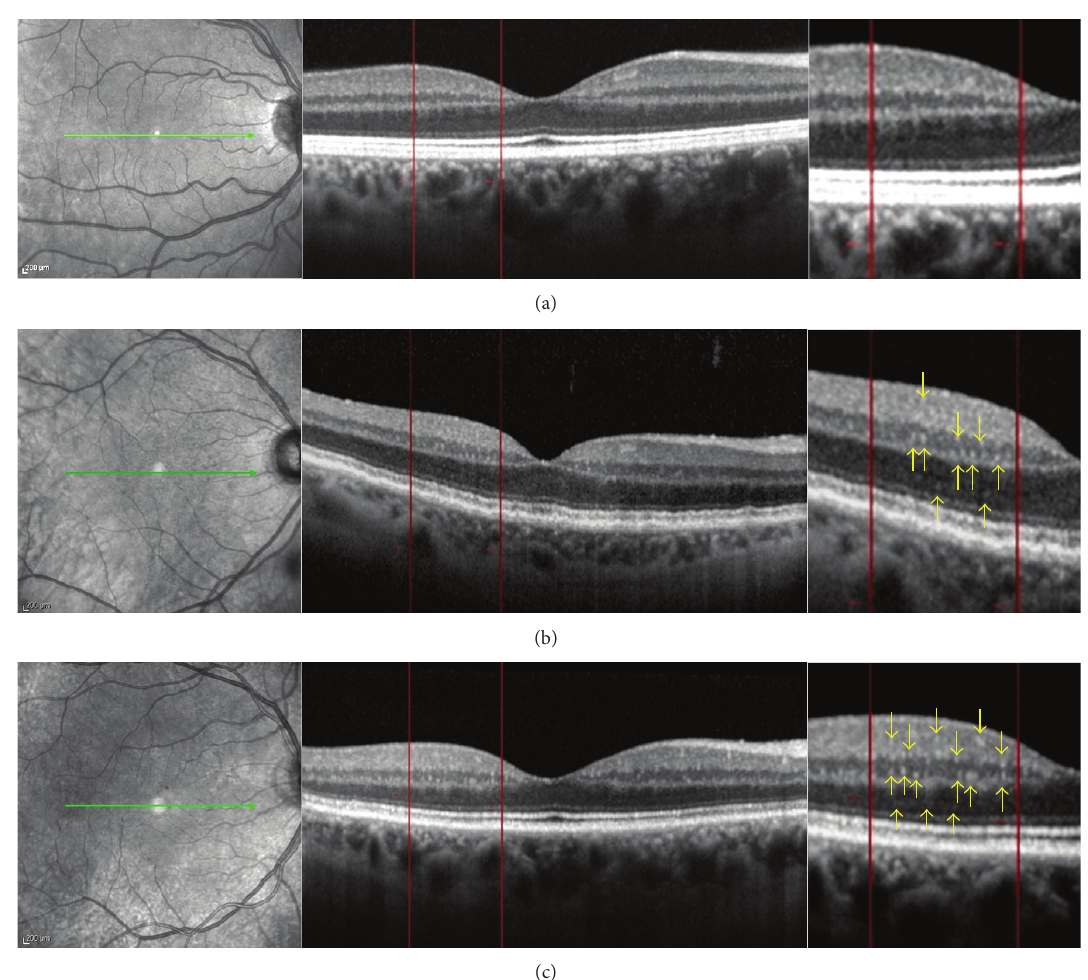
Figure 1: Spectral domain OCT linear scans in the macula of (a) normal subject, (b) diabetic patient without retinopathy, and (c) diabetic patient with mild nonproliferative diabetic retinopathy. Two vertical lines were traced at 500 𝜇 m and 1500 𝜇 m from the center of the fovea in the temporal region where the count of the hyperreflective spots was performed. The count was performed in the following retinal layers: inner limiting membrane (ILM) to ganglion cell layer (GCL), inner nuclear layer (INL) to outer plexiform layer (OPL), and outer nuclear layer (ONL). The yellow arrows indicate the HRS seen on the magnification image. The number of HRS is higher in diabetic eyes with DR versus diabetic eyes without